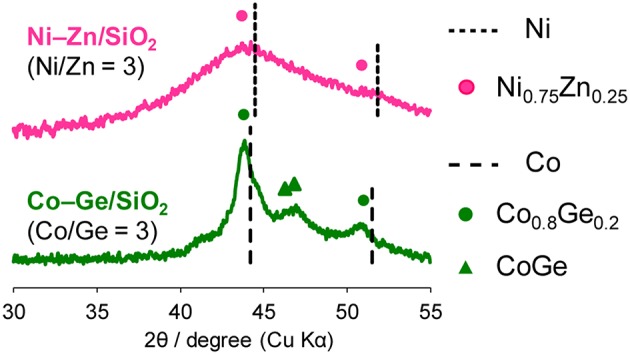
XRD patterns of Ni–Zn/SiO2 (Ni/Zn = 3) and Co–Ge/SiO2 (Co/Ge = 3).